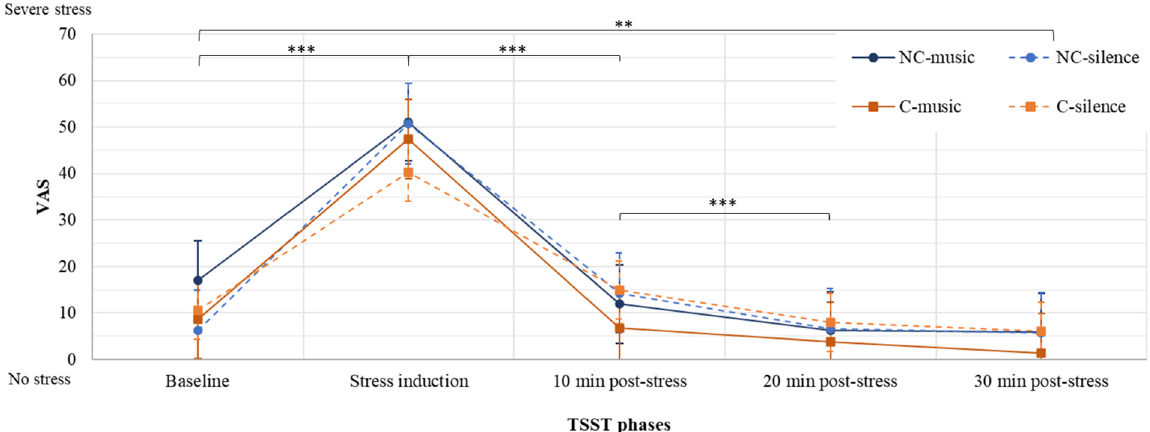
Figure 2. VAS measurements at each time point during the TSST protocol, presented as a function of group (mean ± standard error of the mean). *** p ≤ 0.001. ** p = 0.006.